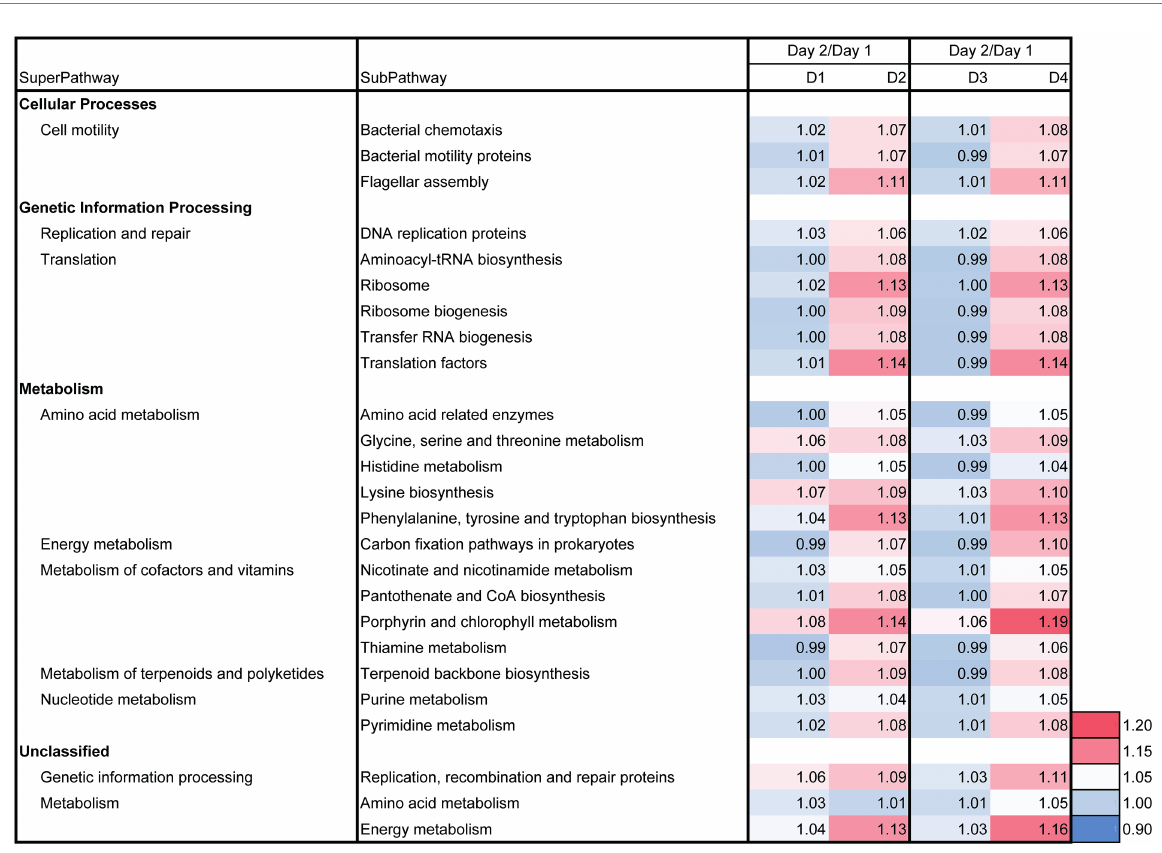
FIGURE 7 Effects of Indigofera tinctoria L. leaf powder (LP) on the ratio (day 2/day 1) for each relative abundance of functional subpathway of the bacterial communities in indigo fermentation using D- sukumo . The batches of I. tinctoria L. leaf powder (LP) added (D2 and D4) and controls (D1 and D3) are shown. In addition, the metagenomic prediction produced using PICRUSt2 and BURRITO is shown. Subpathways containing ratios higher than 1.05 were